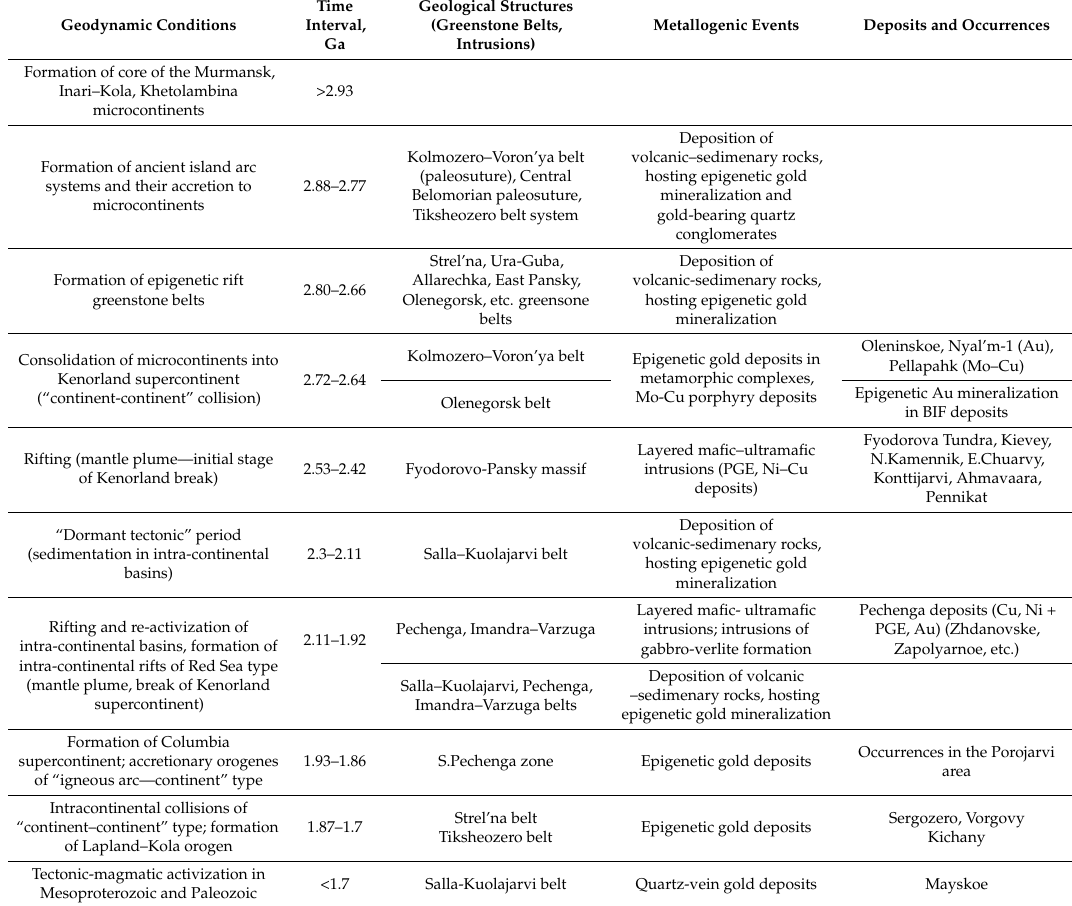
Table 10. The main stages of formation of gold and gold-bearing deposits and occurrences in the northeastern part of the Fennoscandian Shield (based on data from References [8,32,52]). Time Geological Structures Geodynamic Conditions Interval, (Greenstone Ga